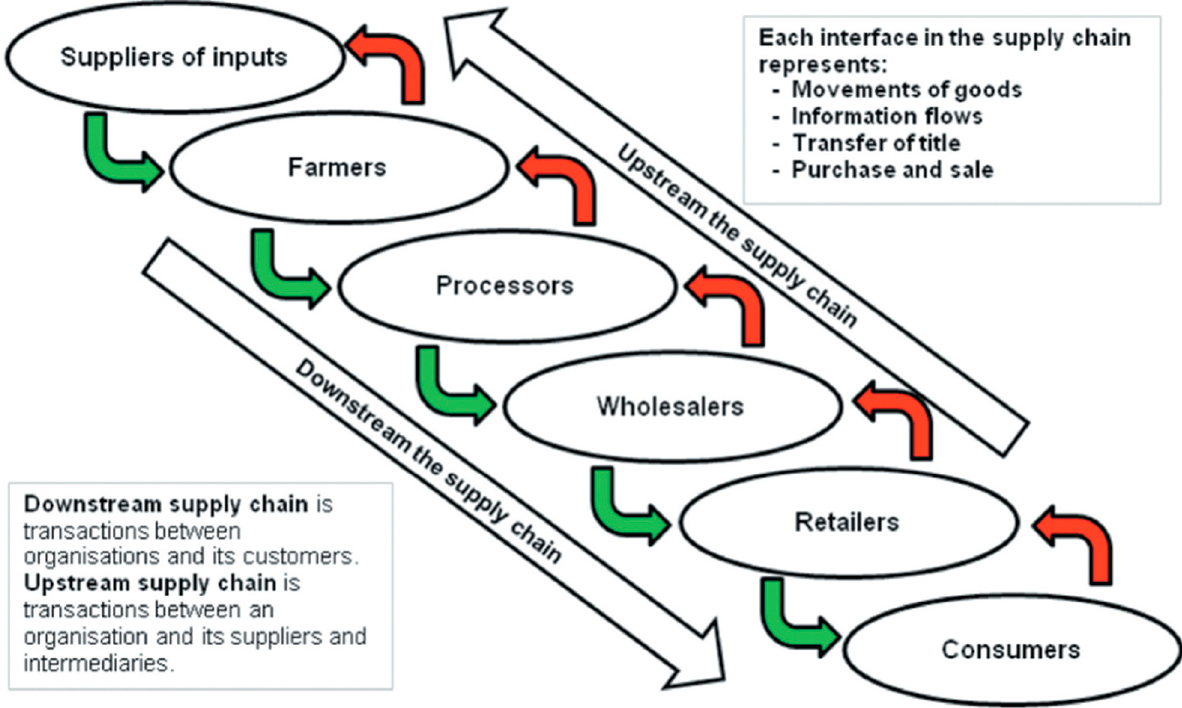
Figure 1. A diagrammatic representation of a typical agrofood product supply chain. From the consumers to the suppliers, the downstream (green) and upstream (red) direction flow of transactions takes place within the supply chain (Source: Costa-Font & Revoredo-Giha, [4]; Open access platform of London School of Economics Business